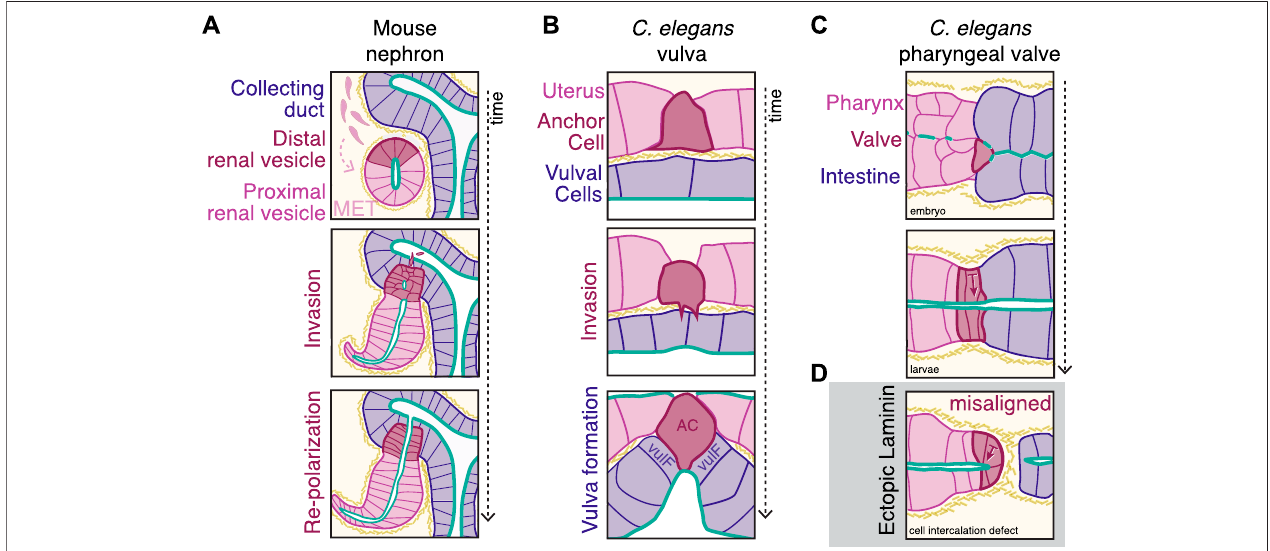
FIGURE 2 | Basal docking connects epithelial tissues that fuse during development. (A) Mammalian kidneys develop from the fusion of two epithelial types: the collecting duct (blue, CD) and the renal vesicle (pink/dark red) that forms from a mesenchymal epithelial transition (MET) of the surrounding cells. Cells of the distal renal vesicle (dark red) lose apico-basolateral polarity and invade into the CD, reaching the lumen. These distal cells then repolarize to form a continuous apical connection (green), enabling further elaboration of the nephron structure. Kidney outlines modi fi ed from (Kao, 2013). (B) The C. elegans reproductive tract connects from the uterus (pink) to the vulval epidermal cells (blue, including vulF precursors) via the anchor cell (dark red, AC) that invades through two juxtaposed basement membranes (yellow hashes) over time. (C) During development of the C. elegans digestive tract, the pharynx (pink) connects to the previously polarized intestine (blue) via the pharyngeal valve cells (dark red) toform a continuous apical (green) midline. (D) In animals with cellintercalation defects, ectopic accumulation of laminin (yellow hashes) causes misalignment of valve cell polarity (arrows show basal | — > apical